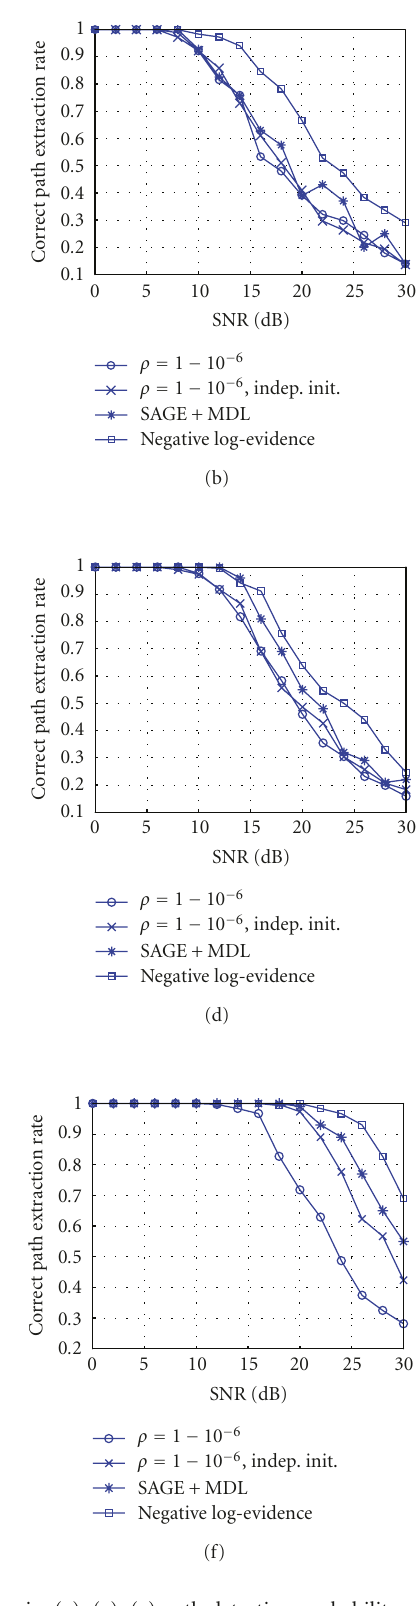
Figure 12: Comparison of the model selection schemes in a single path scenario. (a), (c), (e) path detection probability, and (b), (d), (f) probability of correct path extraction for P = 5, and (a), (b) N s = 1; (c), (d) N s = 2; and (e), (f) N s =